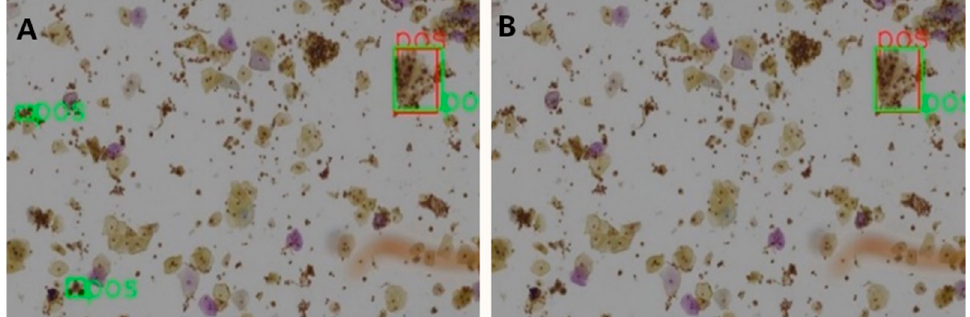
Figure 5. A zoomed display for the detection results without ( A ) and with ( B ) tagging of the negative image samples. The red-colored box indicates the positively labeled ground truth region, while the green-colored regions are detection results of the DGCA-RCNN framework.